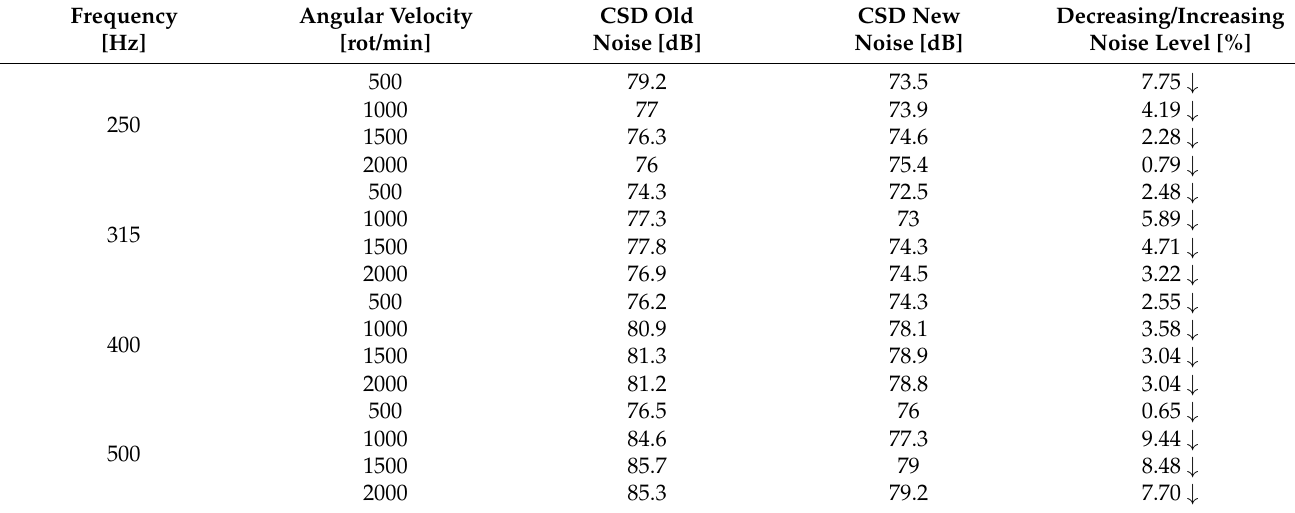
Table A5. Noise level on the rear surface of